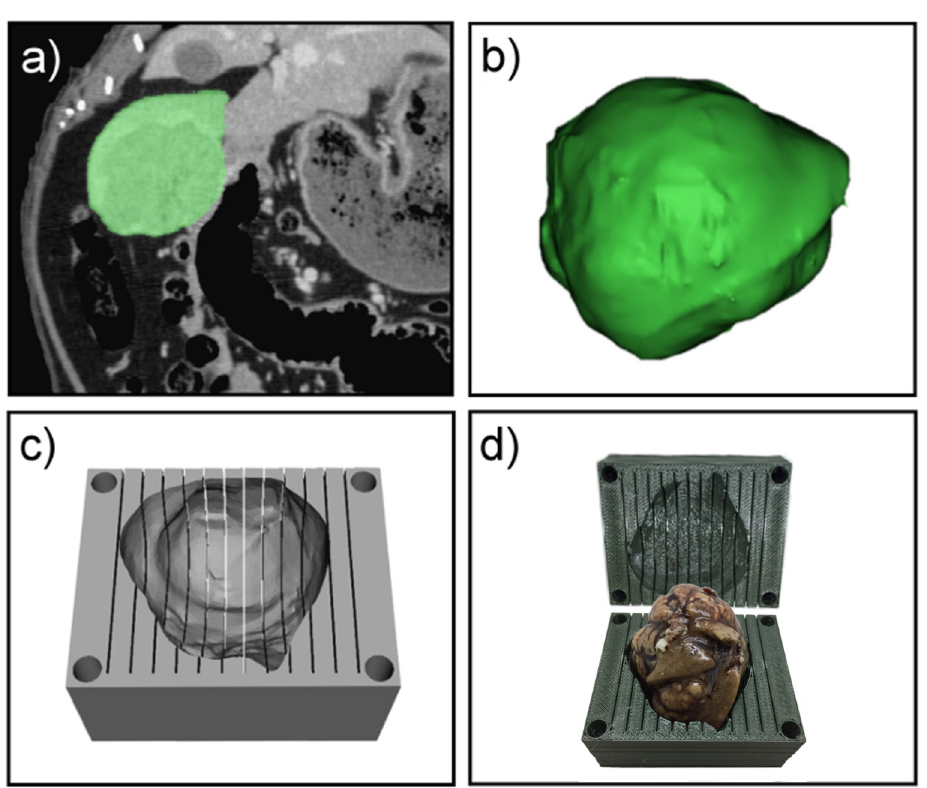
Fig 2. Fabrication of a tumor-specific 3D cutting mold for sectioning liver tumor specimens. (A) Tumor segmentation (green) overlaid on coronal CT, portal venous phase; (B) 3D model of segmented pedunculated tumor; (C) computer-aided design of mold (one side) with tumor-specific cavity and cutting slots in the axial plane; (D) formalin-fixed tumor inserted into the cavity within the tumor-specific 3D cutting mold resulting in alignment of the specimen with the axial CT imaging